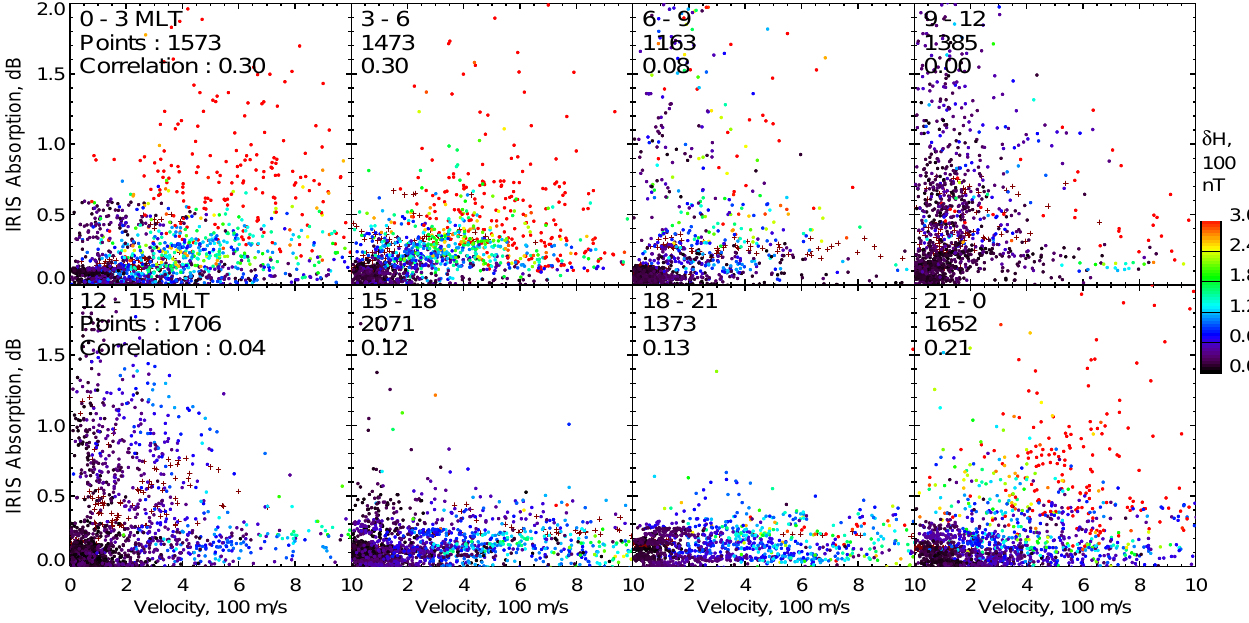
Fig. 5. Same as Fig. 3 except absorption and velocity are compared and colour-coded in